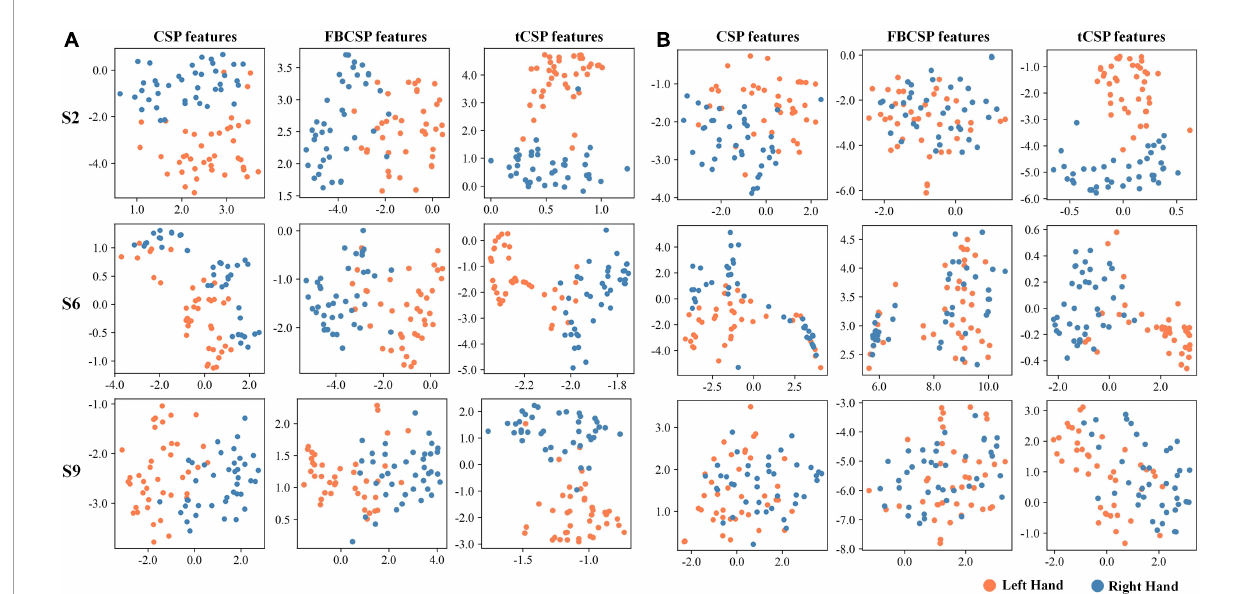
FIGURE5 Feature visualization of different methods using t-SNE. Orange dots indicate samples of left-hand MI tasks, blue dots indicate right-hand MI tasks. The training processes used 40 samples (A) and eight (B) .